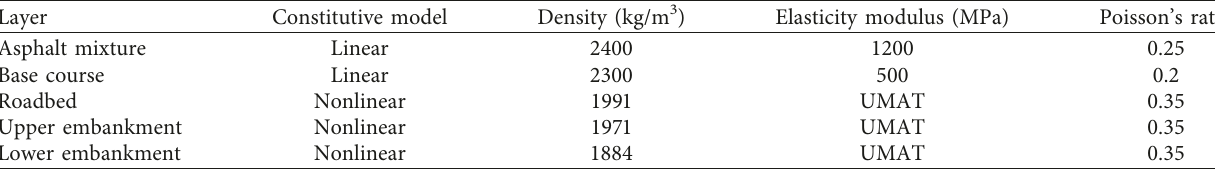
Figure 1: Simulated pavement structure and input parameters. Table 1: Parameters and model of pavement